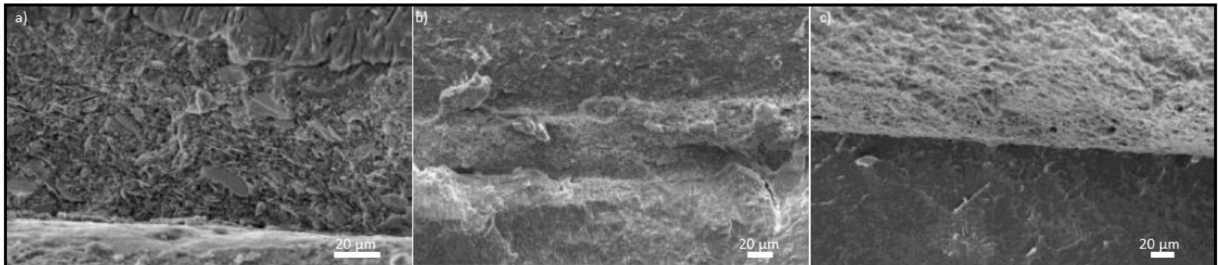
Figure 16. Tight bonding of the root canal layers filled with cold resilon (SEM): ( a ) a thick intermediate layer of sealant covering the prime stud in the apical section; ( b ) a thick sealing intermediate layer covering the additional studs and leakage on the border of the main cone and the complementary material due to delamination of the sealing material in the central part of the root canal; ( c ) three bonded layers: resilon-thick intermediate layer of sealant-dentin of the root canal.